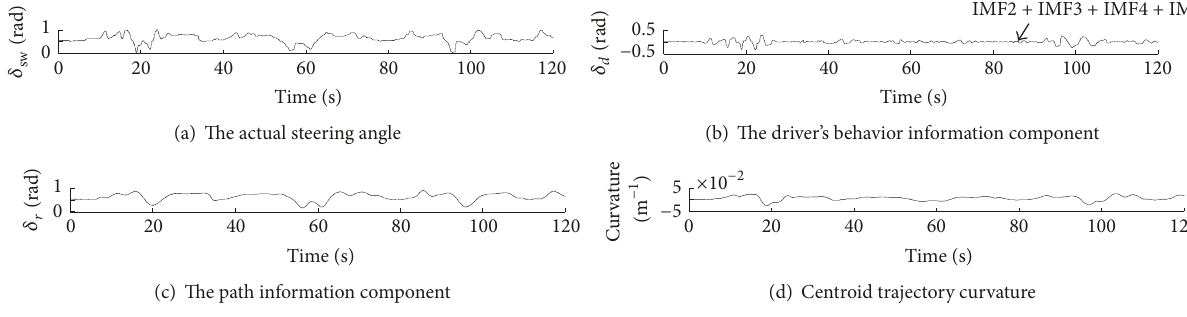
Figure 8: An example of driver’s behavior information